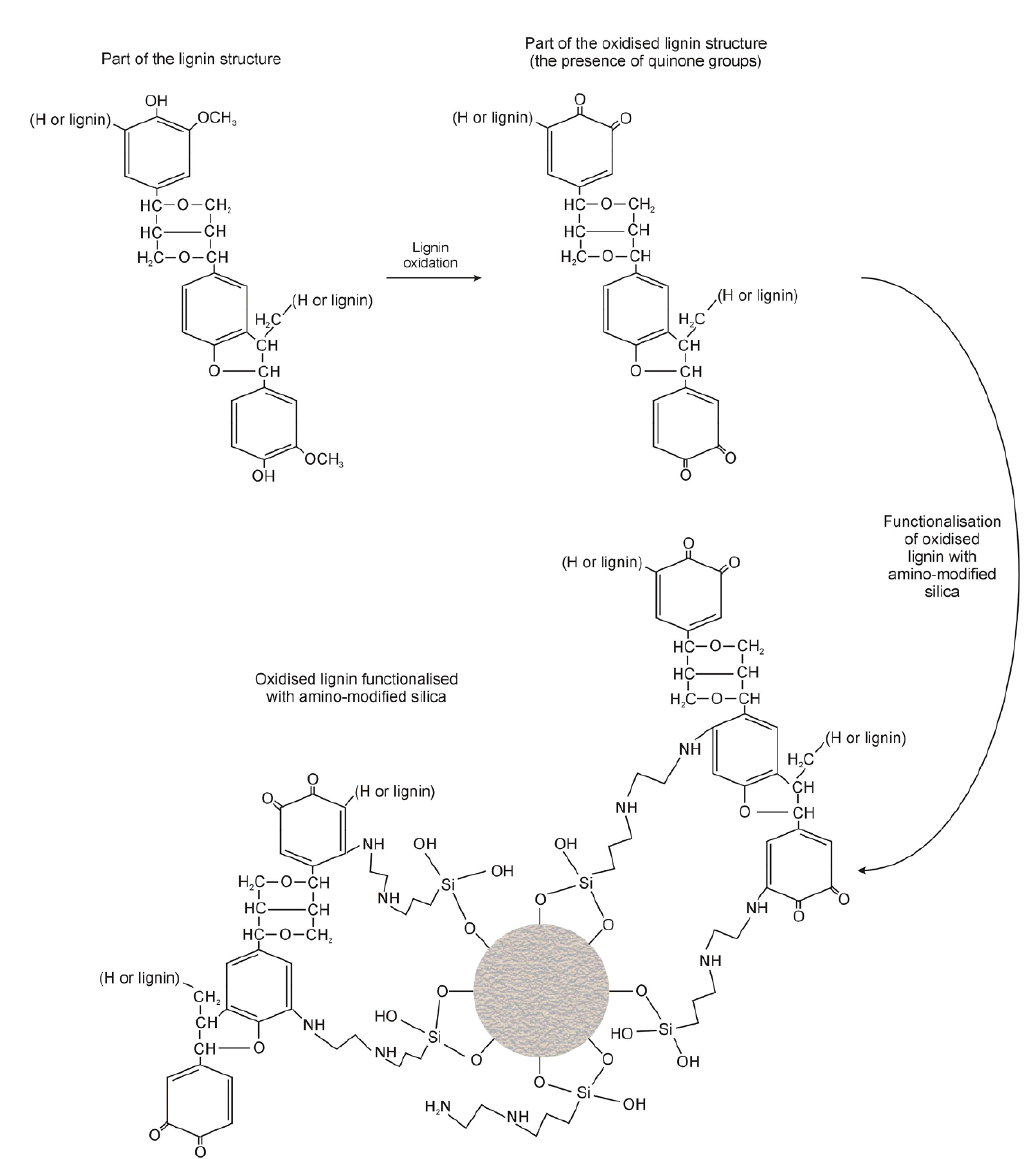
Figure 7. Proposed reaction scheme of the preparation of silica/lignin hybrid biomaterials – functionalisation of oxidised lignin with amino-modified